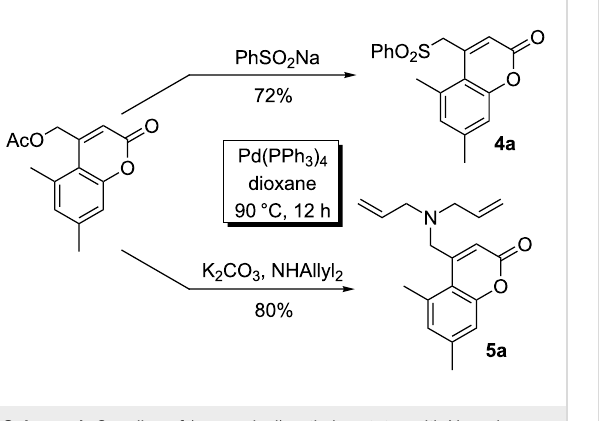
Scheme 4: Coupling of (coumarinyl)methyl acetates with N- and